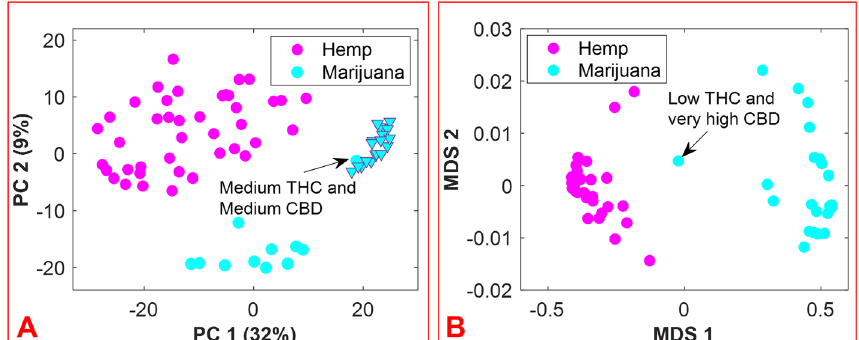
Fig. 3 2D score plot resulting from PCA of hemp and marijuana sample spectra (panel A ); 2D score plot of multidimensional scaling (MDS) analysis of the proximity matrix resulting from the application of supervised random forest (panel B ). The magenta and cyan colors represent hemp and marijuana, respectively. The cyan triangles show the subset of recreational marijuana